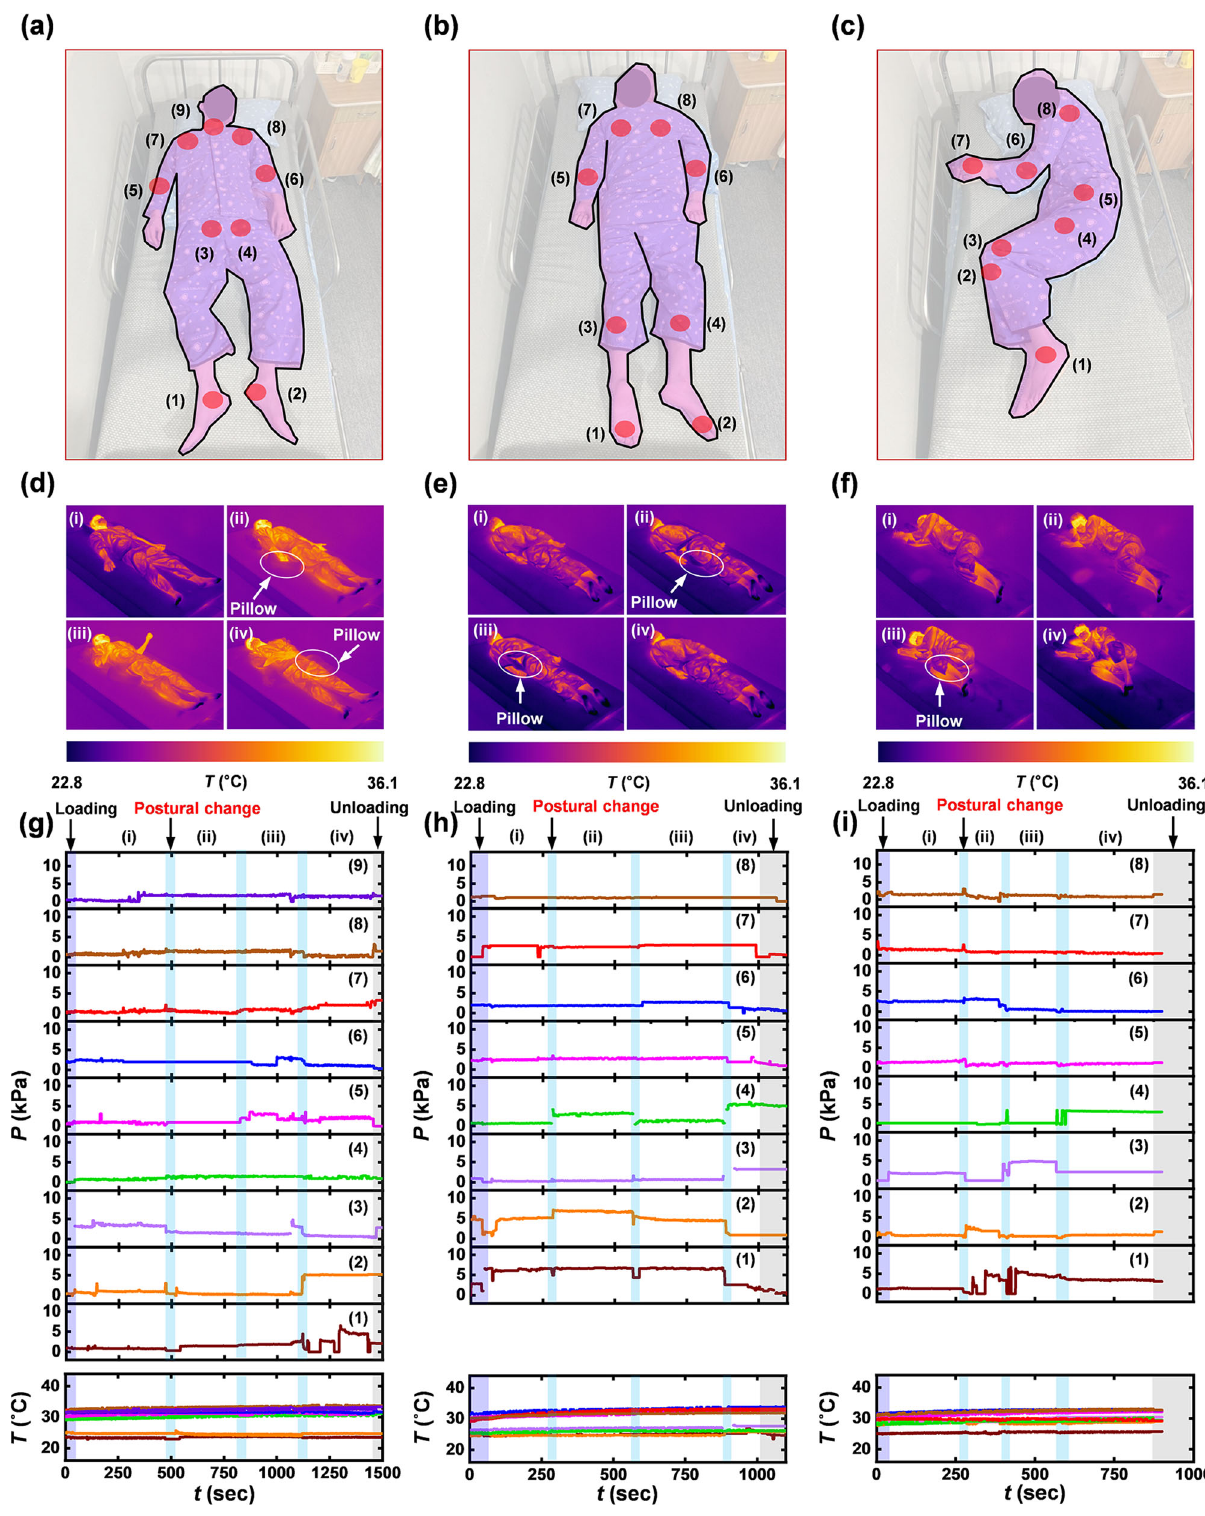
Fig. 5 Continuous measurements of pressure and temperature from a healthy subject (30-year-old male, 72 kg, 180 cm) using the wireless-sensing platform at different lying postures, including supine, prone and side-lying positions, respectively. a – c Photograph and schematic illustration of the subject lying on bed. The red discs highlight the locations of the sensors. d – f IR images of changes in posture of the subject lying on bed with a pillow at different positions. g – i Results from continuous measurements of pressure and temperature from each of the